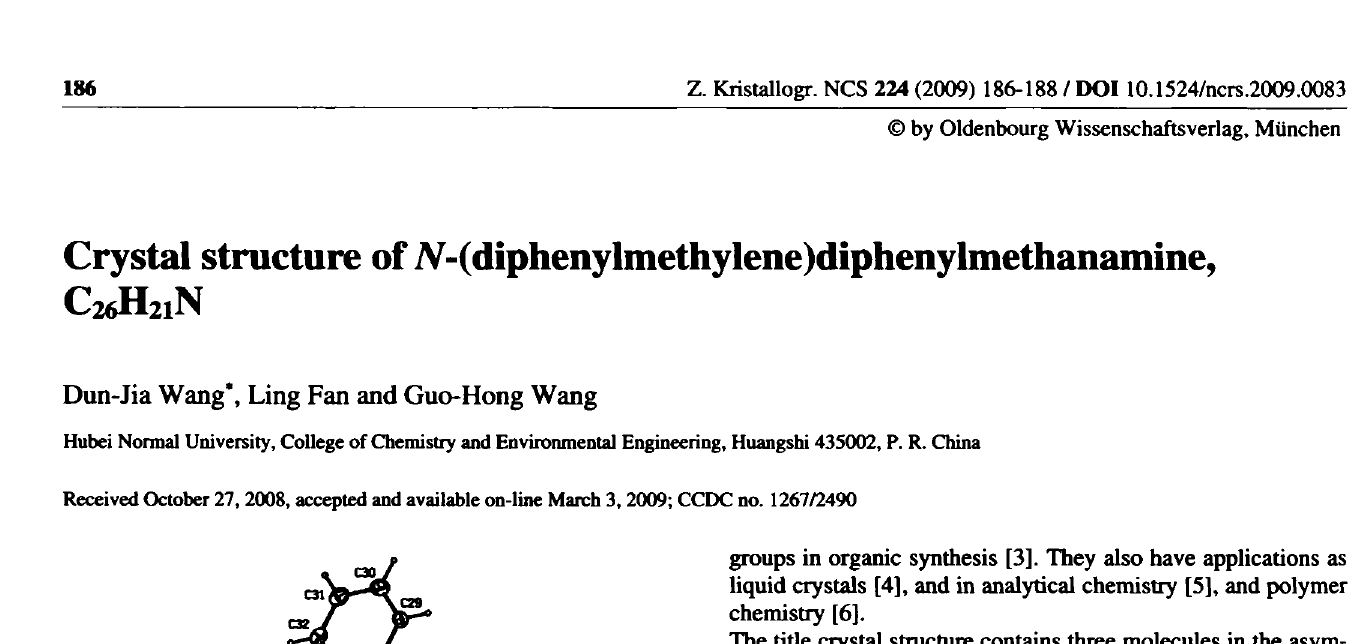
Table 2. Atomic coordinates and displacement parameters (in À 2